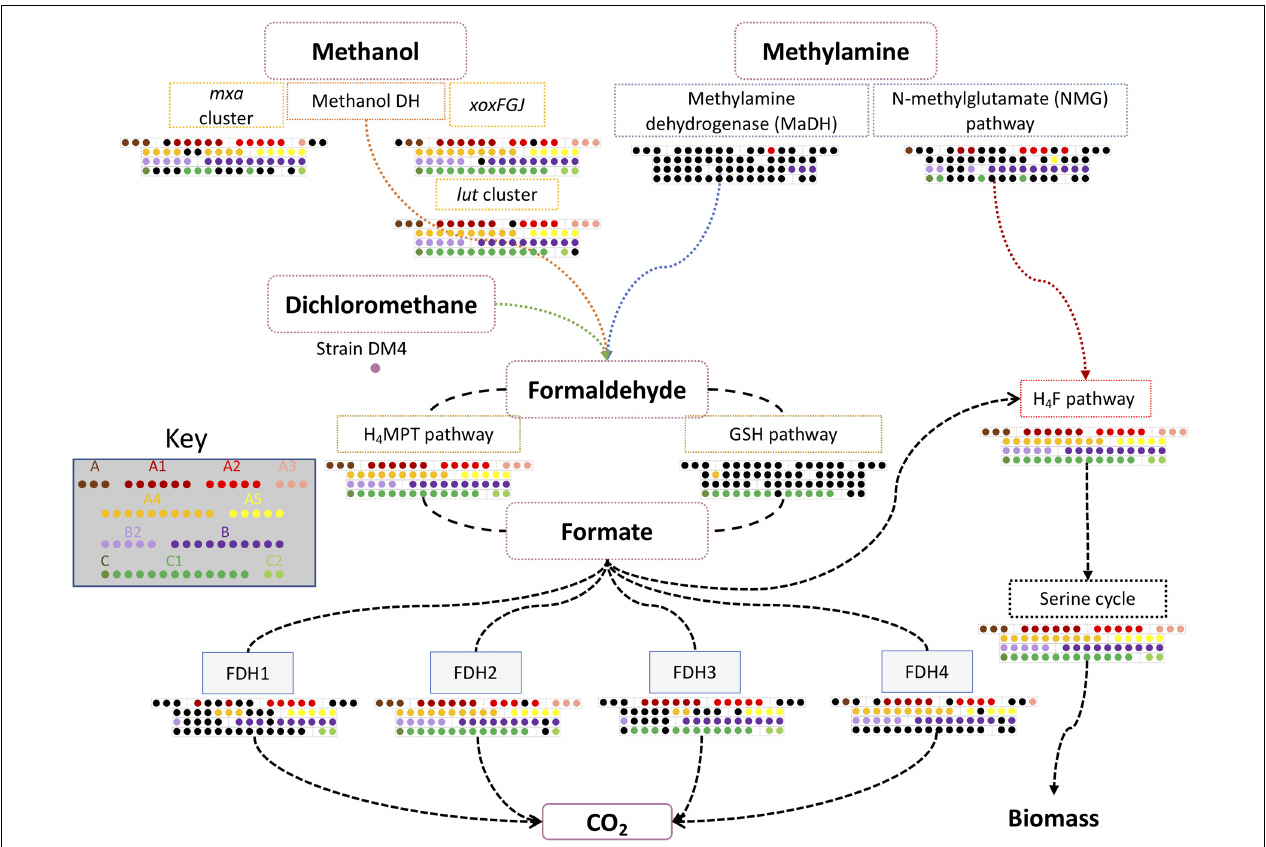
FIGURE 3 | Essential pathways related to C1 metabolism in PPFMs. These pathways include methanol, methylamine, and dichloromethane metabolism. The conservation of gene clusters in each Methylobacterium species is indicated by colored dots. Methylobacterium type strains are arranged in subclades as shown in Supplementary Table 9 . A gene cluster is considered conserved when more than 75% of its genes are present. Black dots indicate a missing cluster or the presence of less than 75% of the gene